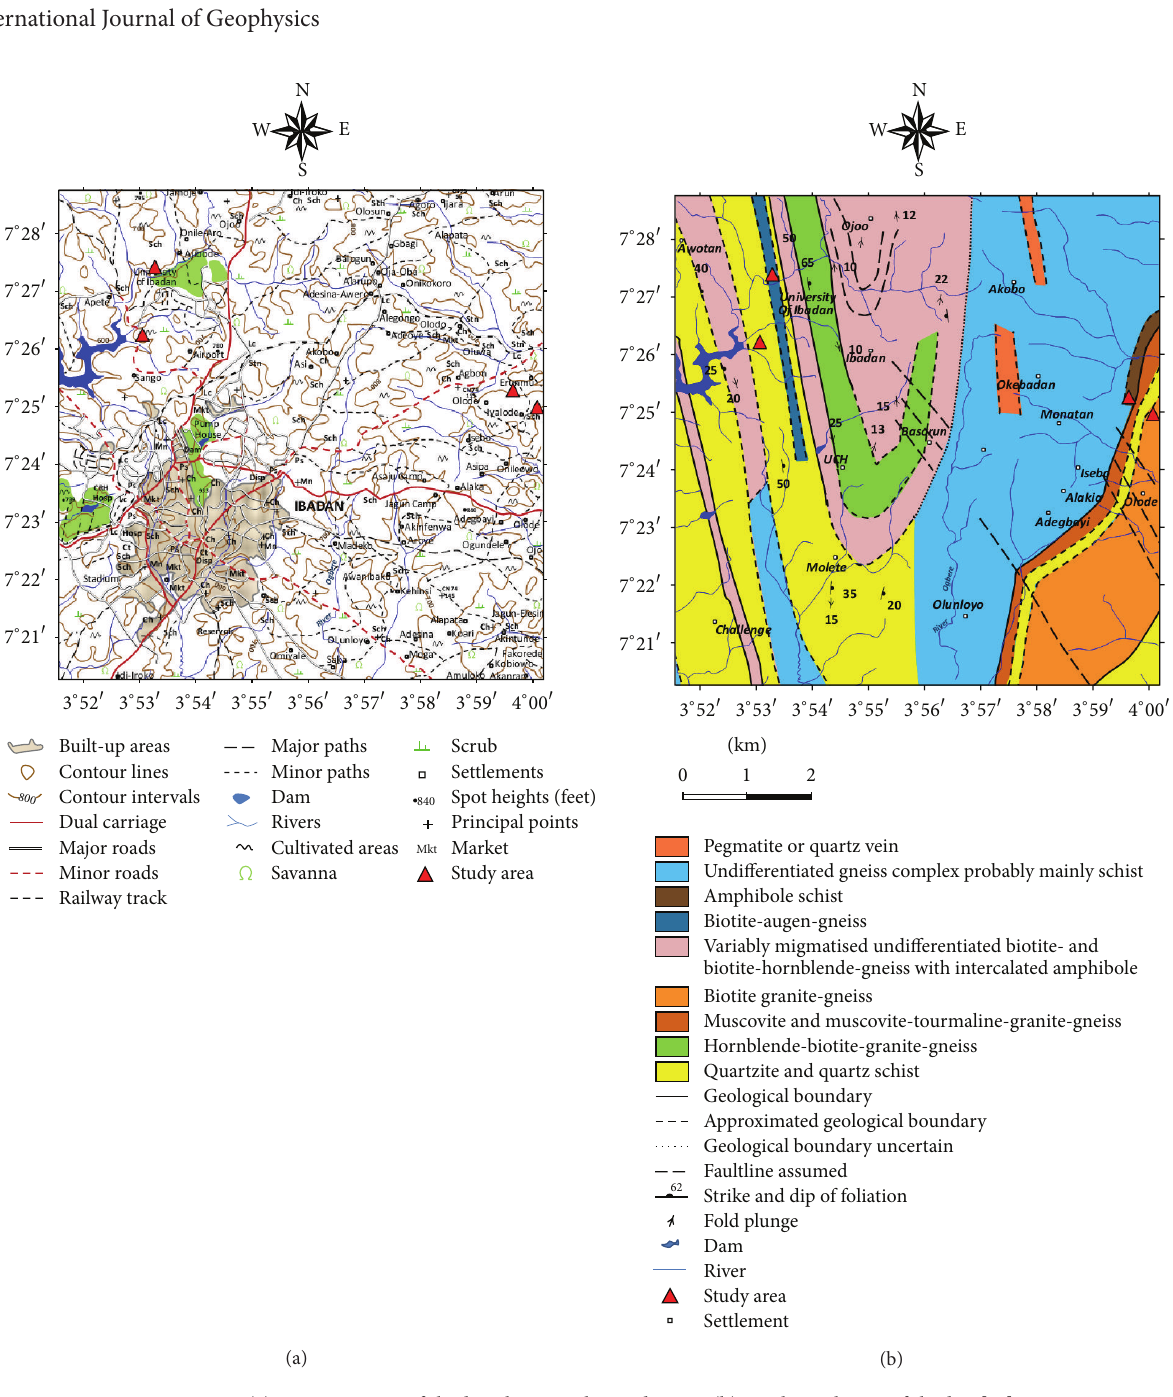
With the expression, the electric field is approximately deter- mined;